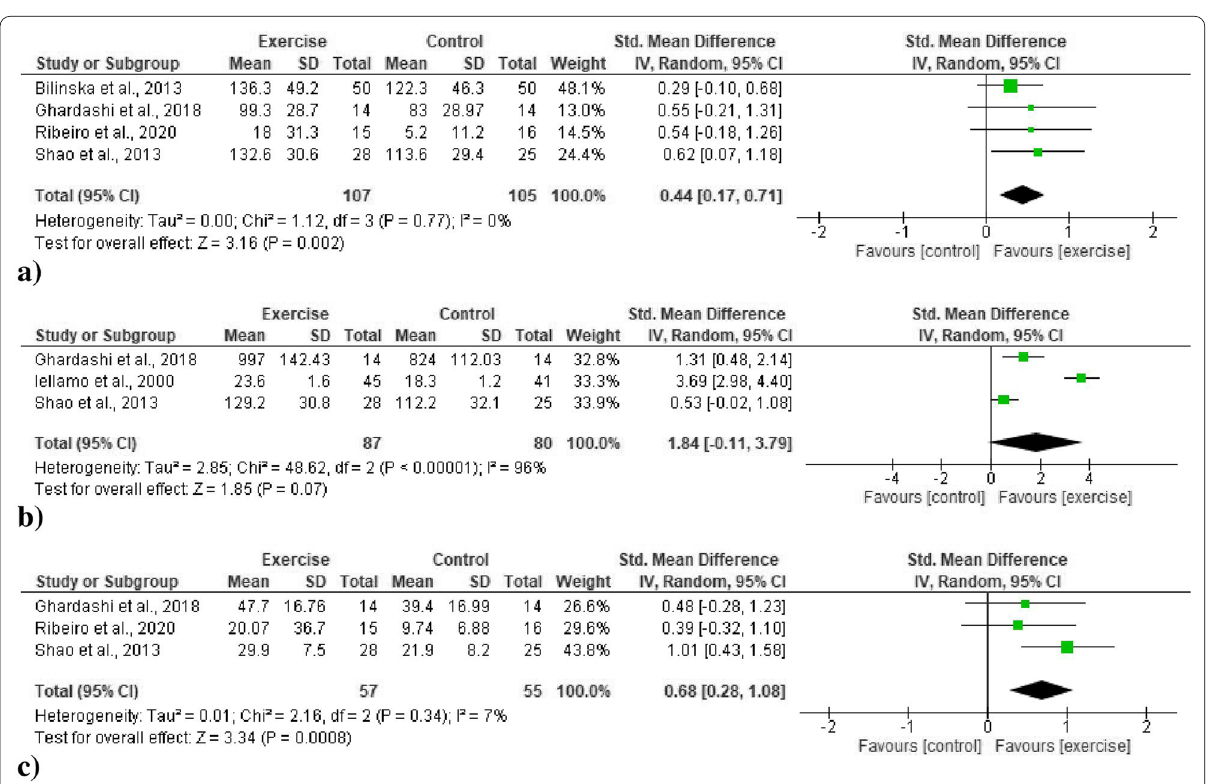
Fig. 2 Forest plots for time domain HRV indices. a Overall changes in standardized mean difference indices for the standard deviation of all RR intervals (SDNN). b Overall changes in standardized mean difference indices for the standard deviation of the 5-min mean RR intervals (SDANN). c Overall changes in standardized mean difference indices for square root of the mean squared differences between successive RR intervals